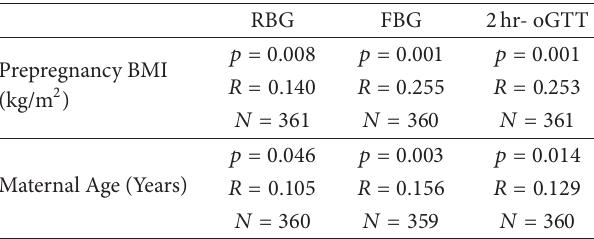
Table 1: The correlations between prepregnancy BMI and maternal age to the different biochemical values. RBG FBG 2hr-